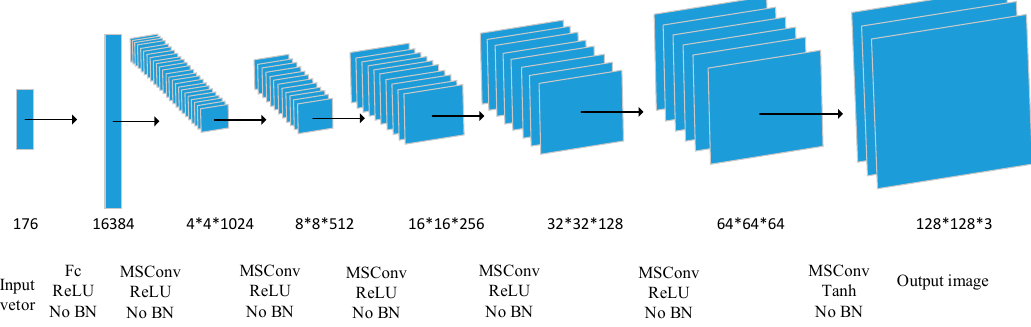
Figure 4. Deconvolution network structure of the generator.